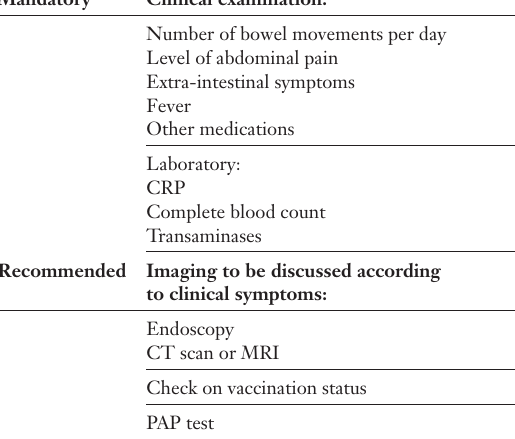
Table 4 Recommendations for general iBD